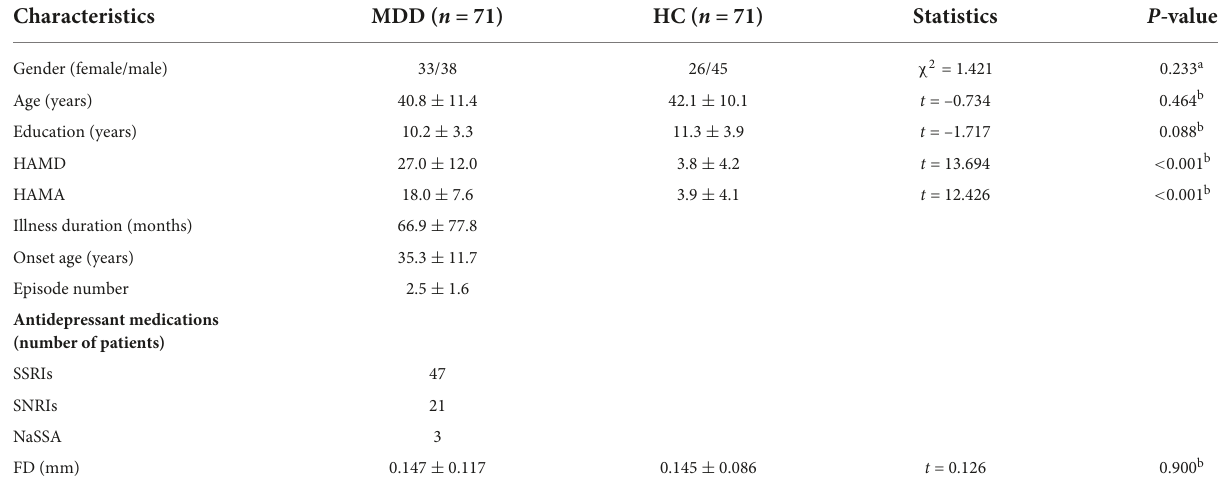
TABLE 1 Demographic and clinical